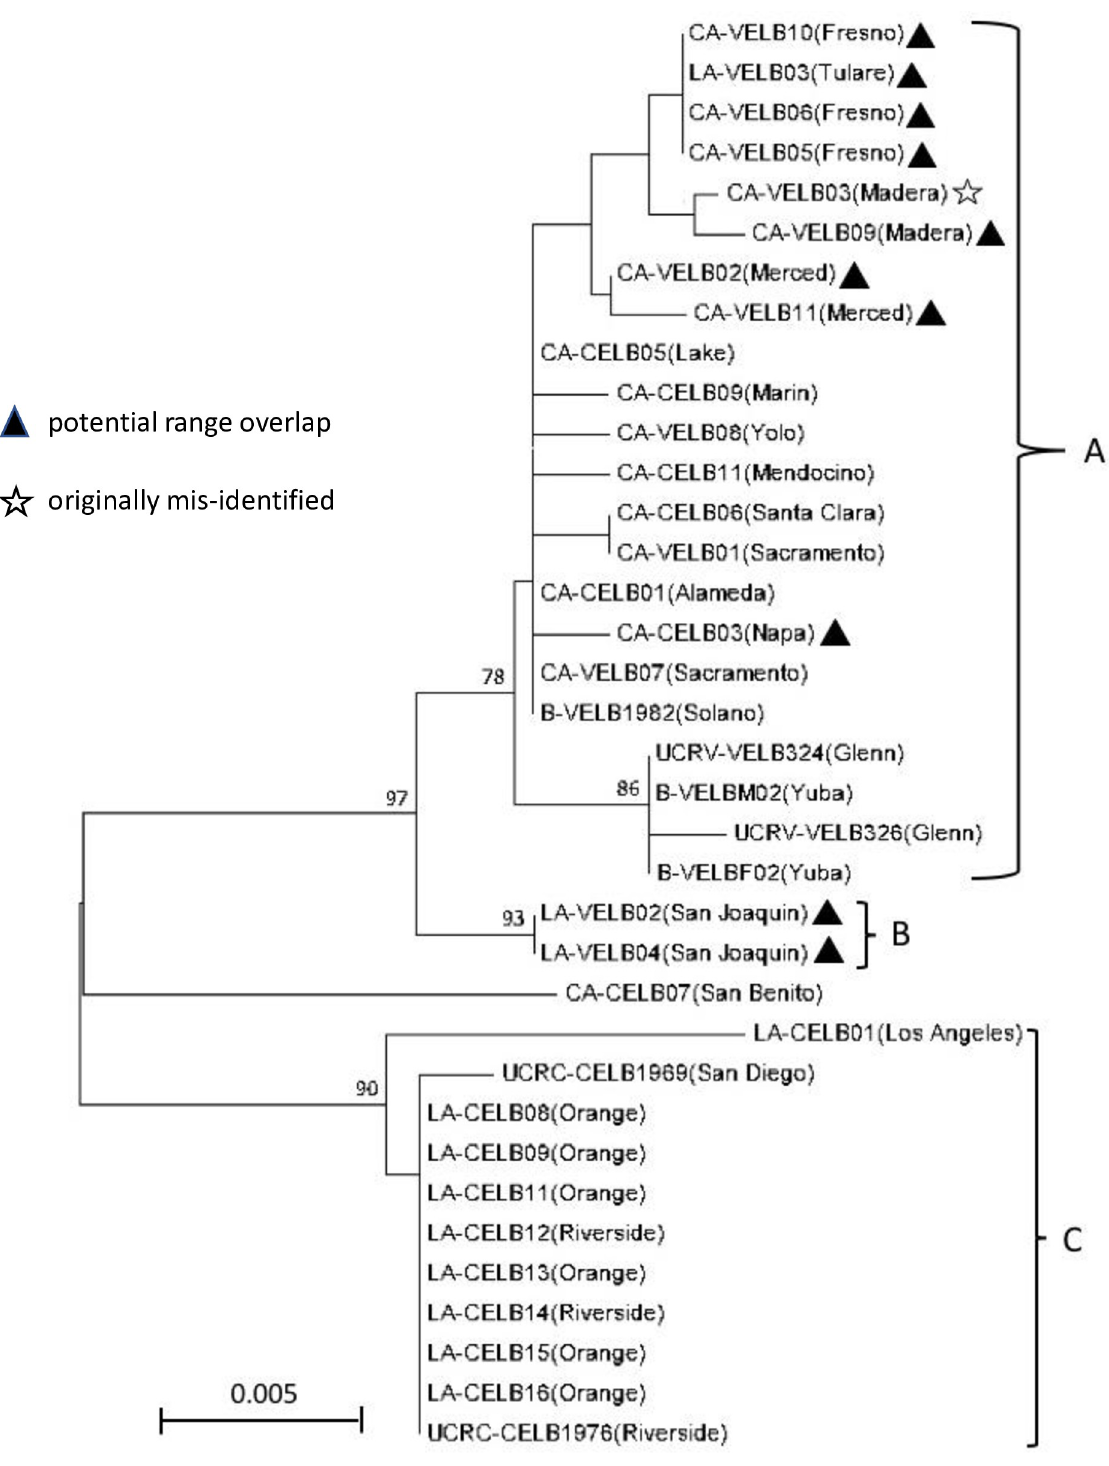
Fig 3. Neighbor-Joining tree constructed from 514 base pairs of the 12S and 16S rRNA genes. The optimal tree with the sum of branch lengths = 0.071 is shown. Three monophyletic clades are labeled “A,” “B,” and “C.” Bootstrap values for highly supported nodes ( > 75%) are shown above the branches. Nodes without values indicate poor ( < 75%) bootstrap support. County from which each sample was collected is in parentheses, triangles indicate samples from areas of potential range overlap, and a star indicates a museum specimen initially misidentified as